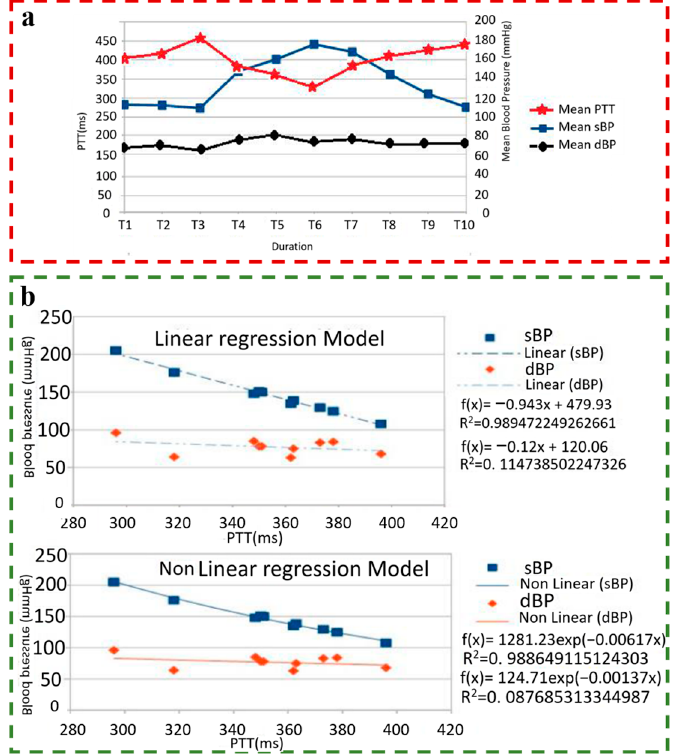
Figure 15. ( a ) Mean PTT, Mean SBP, and Mean DBP from subjects; ( b ) Best-fit curves for patients using the linear regression model and non-linear regression model. Reproduced with the permission of [79]. Copyright 2017, IEEE.